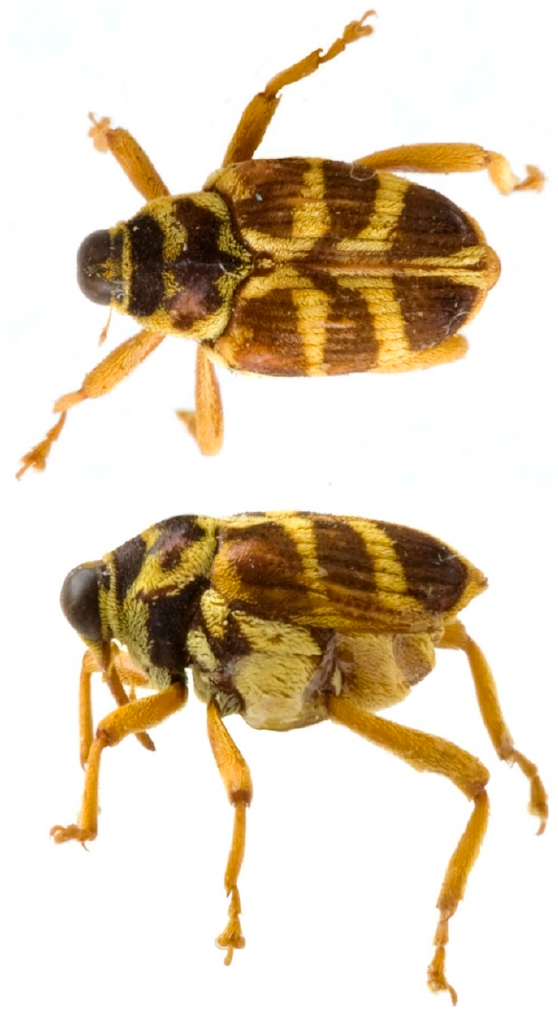
Figure 1. Philenis flavipes Champion, Holotype, dorsal and lateral habitus.